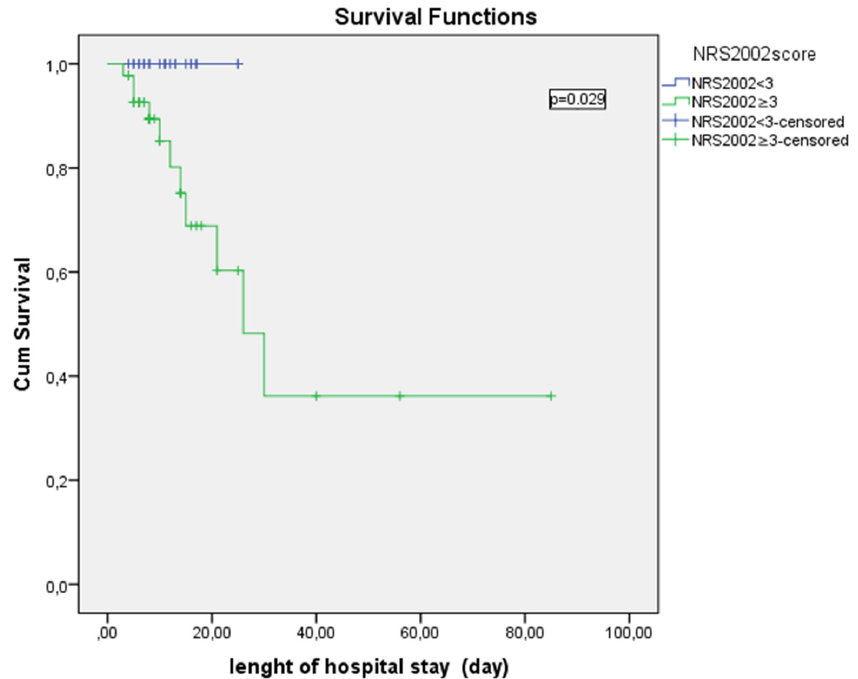
Figure 1. Kaplan ‐ Meier Plots Showing Survival of Patients. Kaplan ‐ Meier survival analysis demonstrated a significantly longer hospital survival in patients with Nutritional Risk Screening 2002 (NRS 2002) score <3 compared with patients who had NRS 2002 score ≥ 3 on admission. Patients were censored at discharge for this analysis.